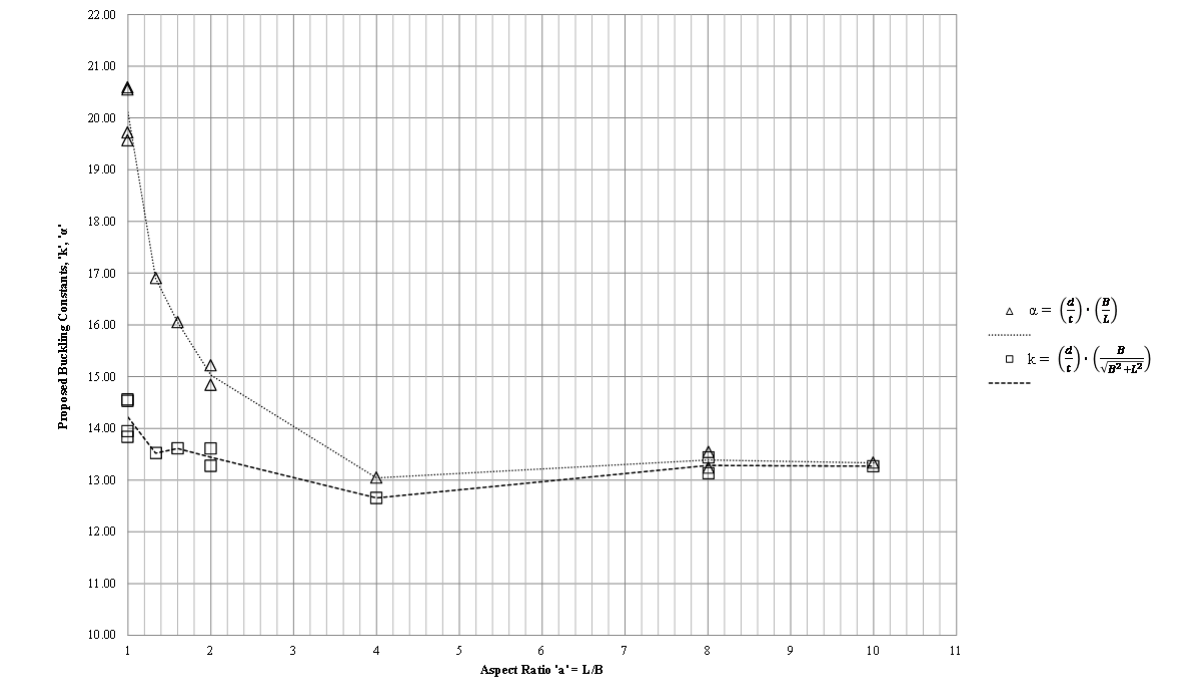
Fig. 6 Investigation of Buckling Ratio at Observed Buckling Point in Preliminary Finite Element Models For comparison sake, the experimental and analytical results from the previously conducted Enclos tests were re- analyzed and plotted using the ratio, k . The ratio, k fits well with the buckling observations from the earlier tests, as seen in Fig. 7 and